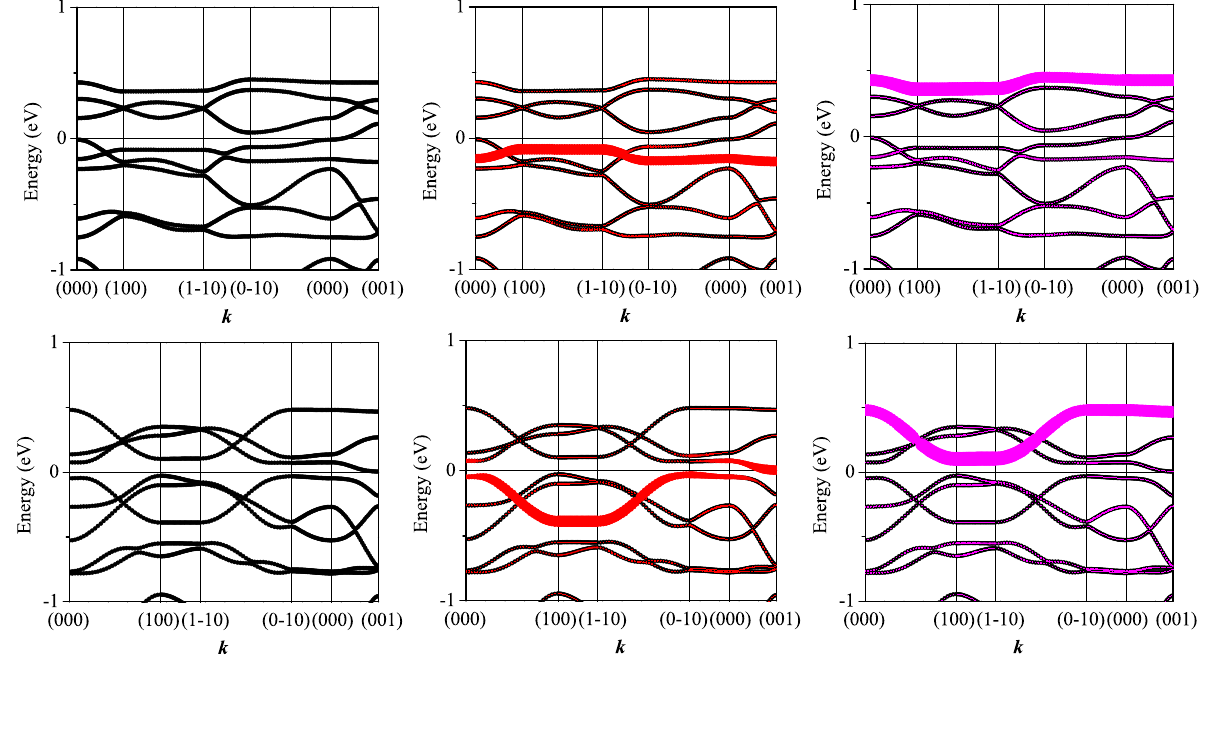
Figure 9. Electronic band dispersions (left) and Cu(1) 3d (center) and Cu(2) 3d (right) contributions therein for antiferromagnetic Cu(tmdt) with the unit cells of (2 a ; b ; c ) (upper) 2 and ( a ; 2 b ; c ) (lower). The labels (1) and (2) distinguish two Cu atoms in the unit cell. k vectors are shown in units of ( a */2, b */2, c